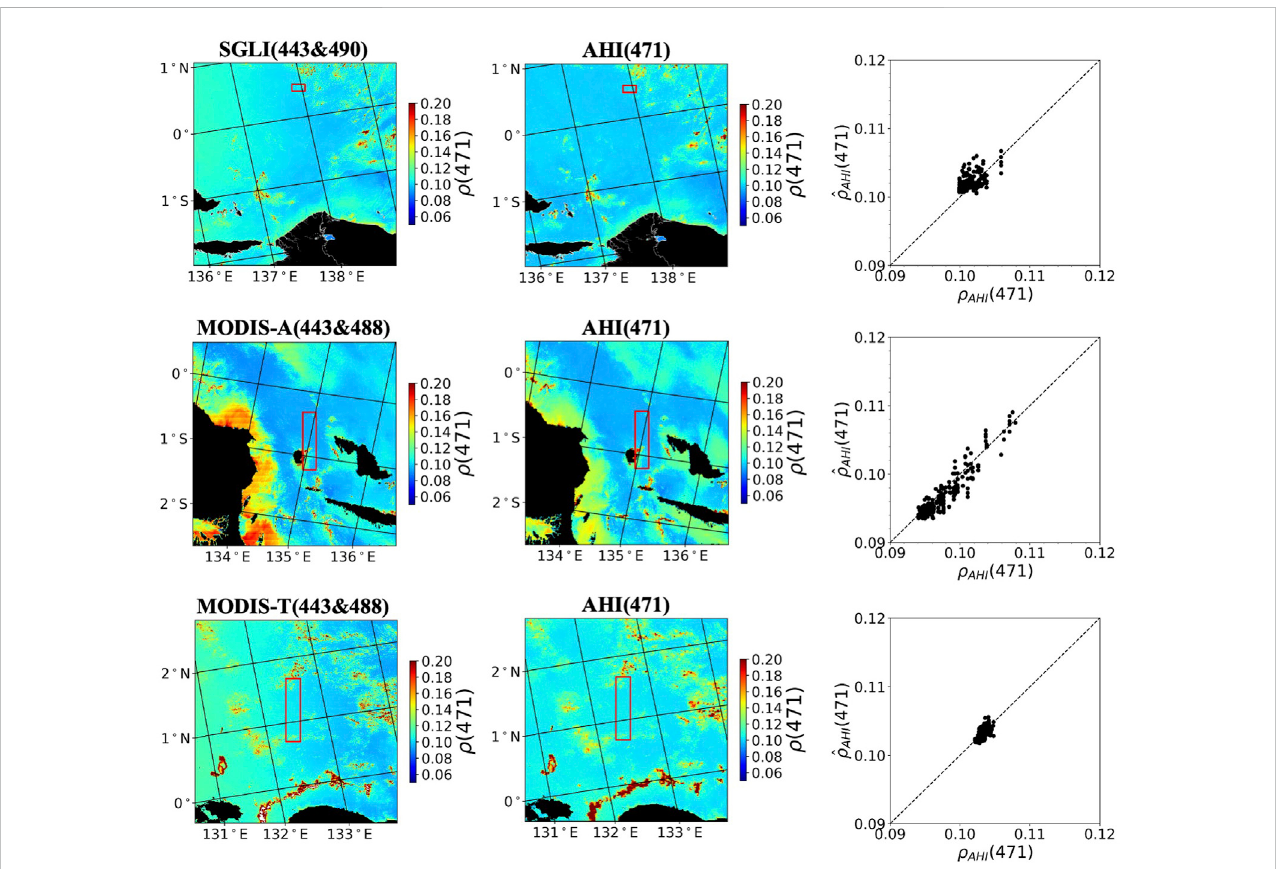
FIGURE 2 Concomitant SGLI/AHI (01:10 GMT, top row), MODIS-A/AHI (04:30 GMT, middle row), and MODIS-T/AHI (01:30 GMT, bottom row) images of TOA re fl ectance for 25 January 2020. The Level 1b SGLI, AHI, and MODIS data used to generate these images were downloaded from JAXA ’ s P-Tree system (https://www.eorc.jaxs.jp/ptree/index.html) and G-Portal (https://gportal.jaxa.jp/gpr/), and from NASA's OBPG (https://oceancolor.gsfc.nasa.gov), respectively. The AHI imagery of 471 nm was remapped to the SGLI and MODIS latitude-longitude grid, and SGLI at 443 and 490 nm and MODIS-A and -T at 443 and 488 nm were used to generate the equivalent (i.e., ^ ρ AHI ) AHI image at 471 nm (see Table 2 for the speci fi c coef fi cients to convert polar orbiter re fl ectanceto ^ ρ AHI ).Redrectanglesindicatewherethecoincidentpixelsoccur.Landismaskedasblack.White indicatessaturatedpixels. Therightpanelshow the scatter plots of equivalent versus measured AHI re fl